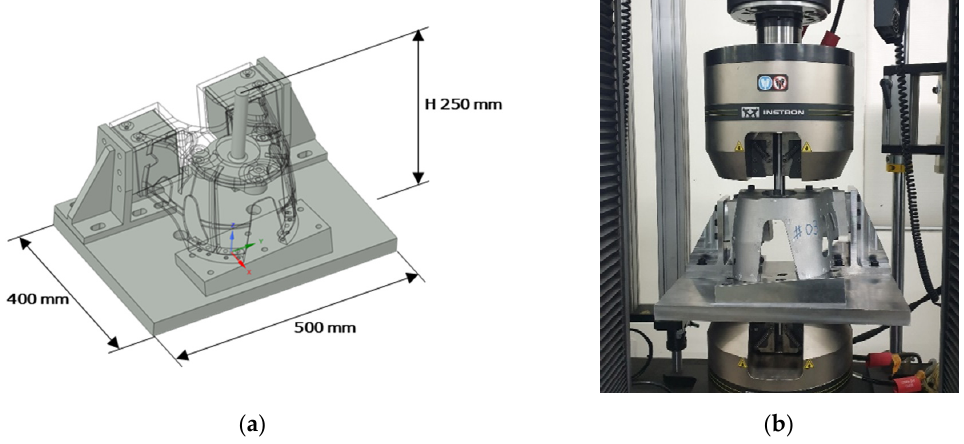
Figure 9. Tensile experiment of shock absorber mount: ( a ) jig design for tensile experiment with dimension; ( b ) shock absorber mount attached to tension equipment.